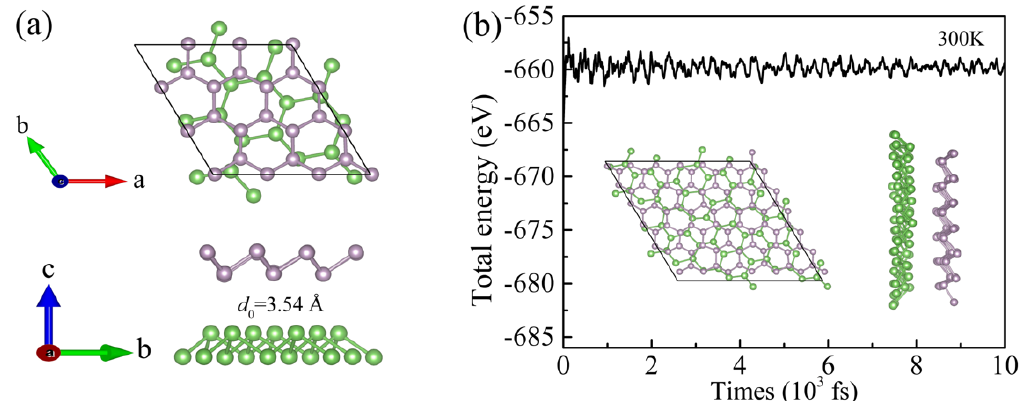
Figure 2. ( a ) Top and side views of the optimized As/BlueP vdW hetero-structure. ( b ) Total energy evolution of the hetero-structure at 300 K from AIMD simulations. Insets depict the snapshot of the hetero-structure at 10 ps from top and side views.